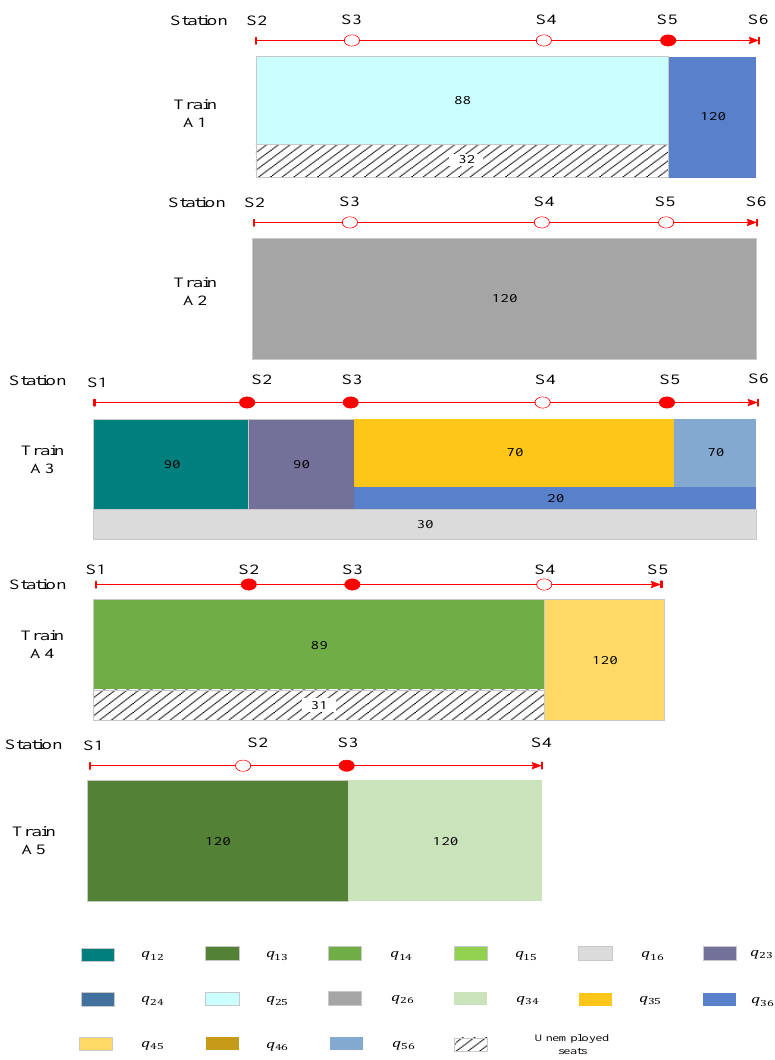
Figure 7. Passenger distribution for additional trains.